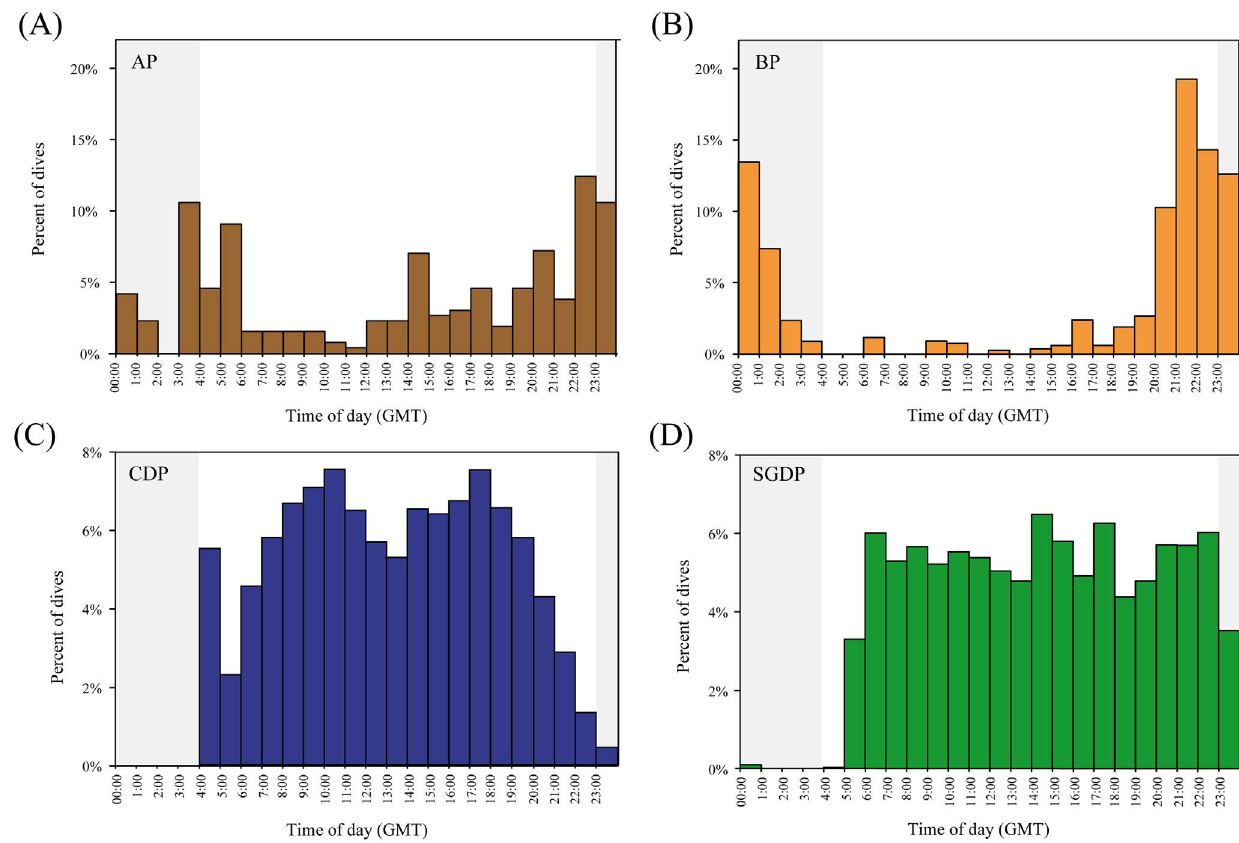
Figure 5. Temporal diving activity patterns. Diel patterns in dive frequency of birds fitted with TDRs loggers during incubation at Bird Island, South Georgia in summer 2010/11. Shaded areas indicate darkness. Species abbreviations: AP (Antarctic prion), BP (blue petrel), CDP (common diving petrel) and SGDP (South Georgian diving petrel).